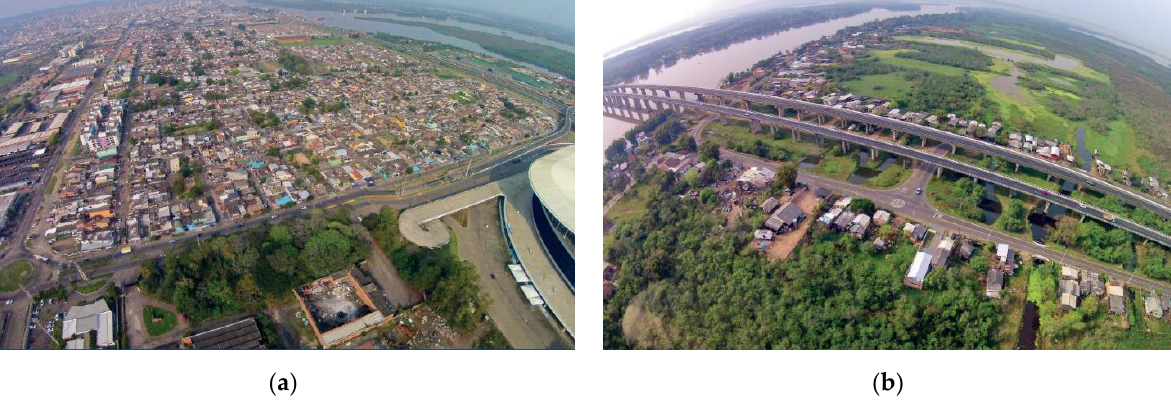
Figure 2. Landscapes in the areas of interest: ( a ) urban pattern in the Humaitá-Navegantes region; ( b ) urban pattern in the Arquipélago region. Source: the World Bank (2017), used under permission.